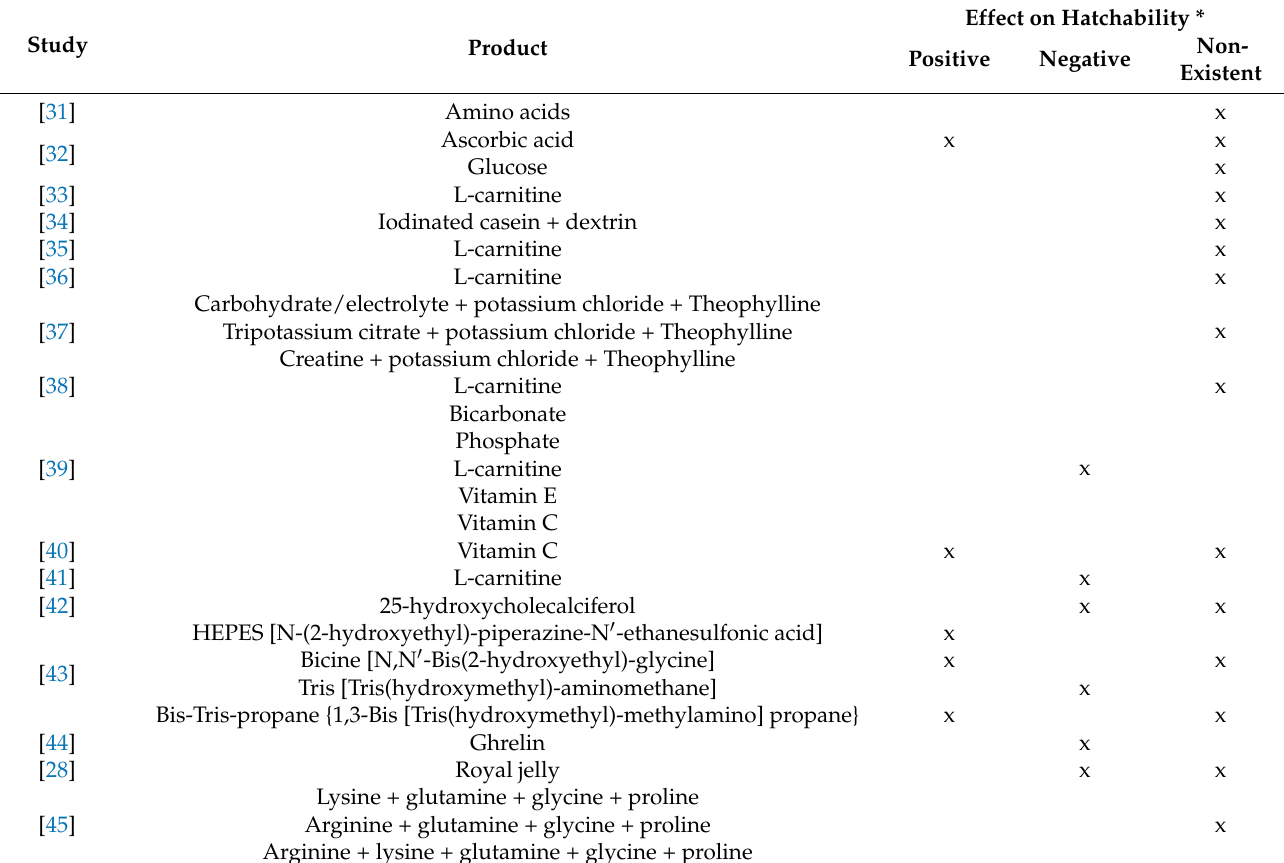
Table 4. Studies reviewed and respective products